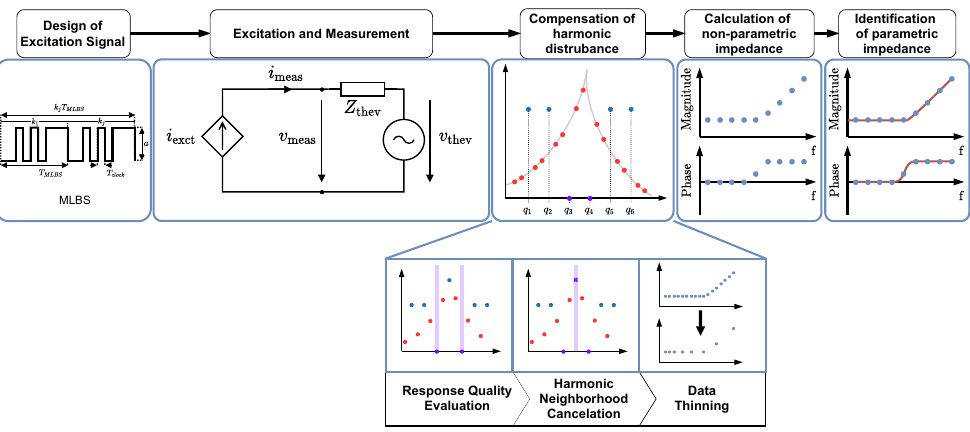
Figure 18. Extended procedure for impedance measurement by proposed compensation